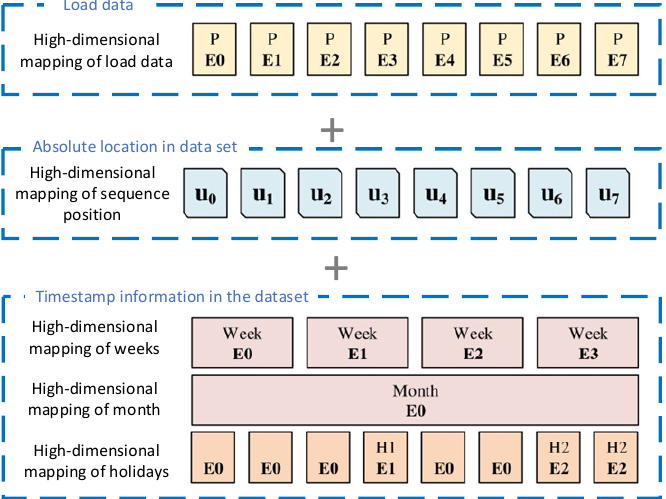
Figure 1. Composition structure of Informer model input.